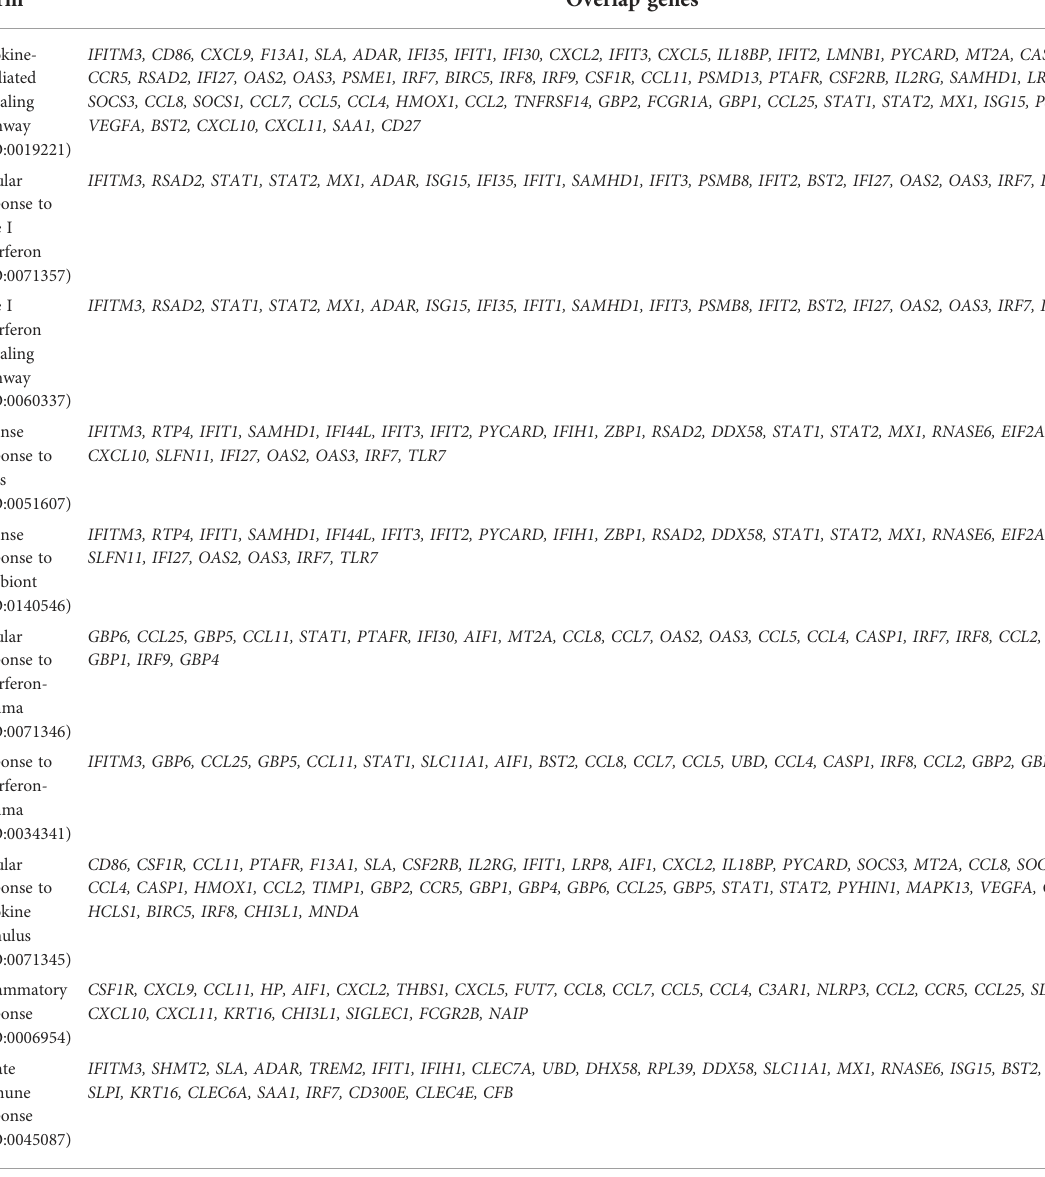
TABLE 2 Top 10 signi fi cant gene ontology (GO) biological process including differentially expressed gene (DEGs) in the lung of SARS-CoV_2- infected hamsters after inoculation of IFN- l s at 3 and 7 dpi. Term Overlap genes cytokine-